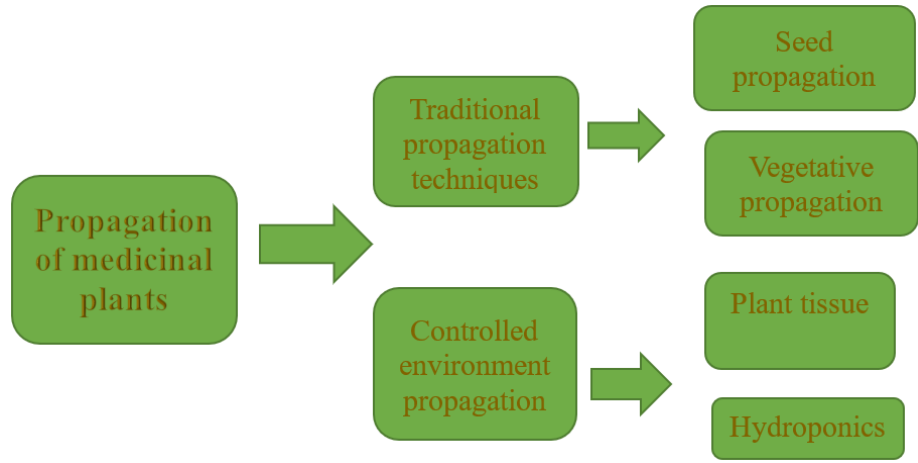
Figure 3. Propagation of medicinal plants in South Africa.